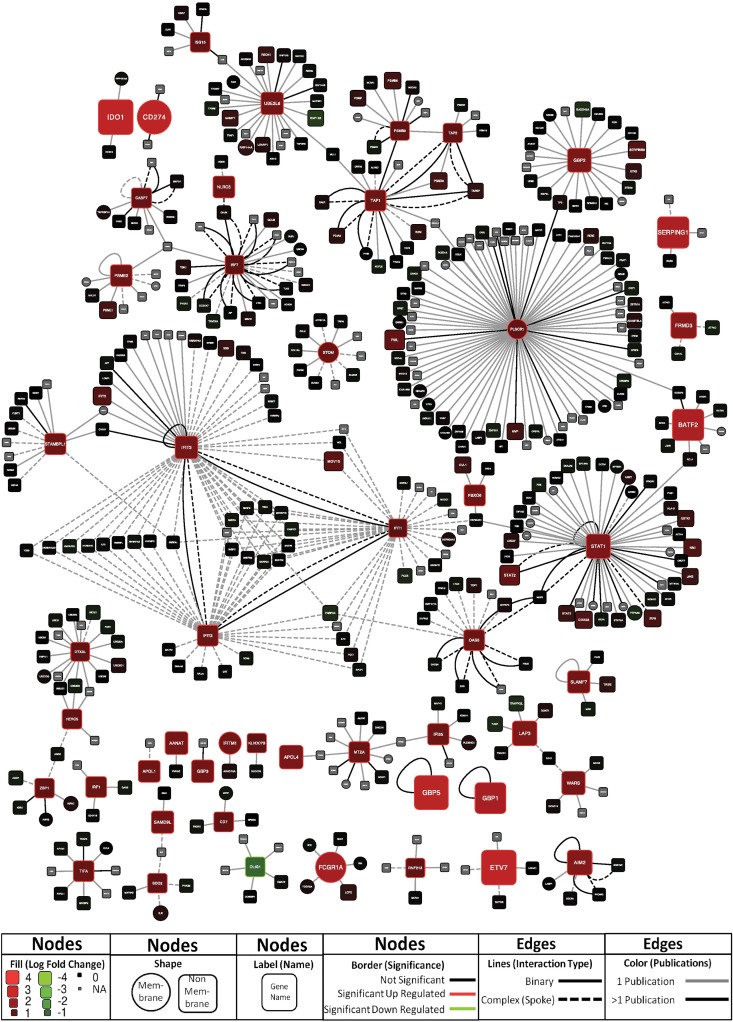
Network analysis of proteins encoded by the 80 core AS03-responsive genes shared between neutrophils, monocytes, and dendritic cells 1 day post-vaccination.Nodes are labeled by corresponding gene name. Edges represent experimentally determined (reported in at least two publications) binary protein-protein interactions or protein complex membership. Color and size of individual nodes indicates the degree of mean log2 fold change difference (LFCD) in corresponding gene expression between vaccine groups. Further details are provided as part of the legend within the figure.